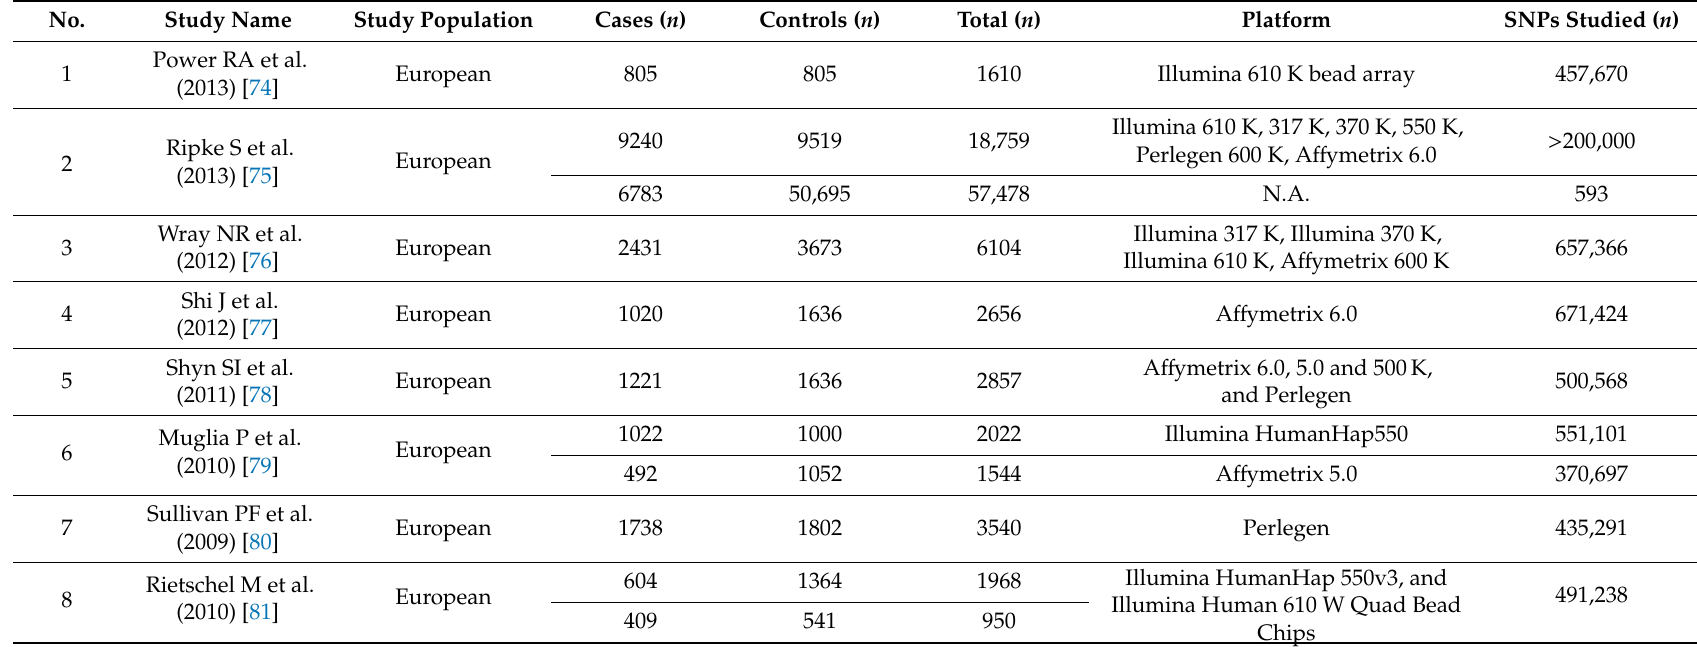
Table 3. Characteristics of genome-wide association studies of major depressive